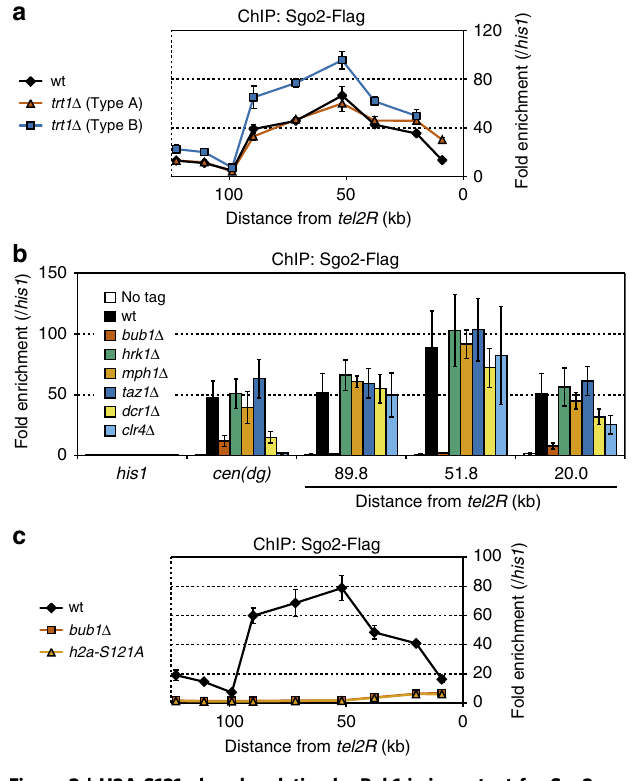
Figure 3 | H2A-S121 phosphorylation by Bub1 is important for Sgo2 association with the subtelomeres. ( a ) ChIP analyses of Sgo2-Flag localization at subtel2R in trt1 D survivor cells (Types A and B). Relative fold enrichment at subtel2R , normalized to the signal at the his1 þ locus, is shown. It is noteworthy that the most telomere-proximal data point, which corresponds to the region lost in Type B, is missing for Type B. ( b ) ChIP analyses of Sgo2-Flag localization in various deletion mutants. Relative fold enrichment at subtel2R and the centromeres ( dg ), normalized to the signal at the his1 þ locus, is shown. ( c ) ChIP analysis of Sgo2-Flag localization at subtel2R in the bub1 D and h2a-S121A mutants. The relative fold enrichment at subtel2R as normalized by the signals at the his1 þ locus is plotted. The error bars indicate the s.d. ( n ¼ 3). Figure 4 | Sgo2 is required for the formation of knobs. ( a ) Co-localization